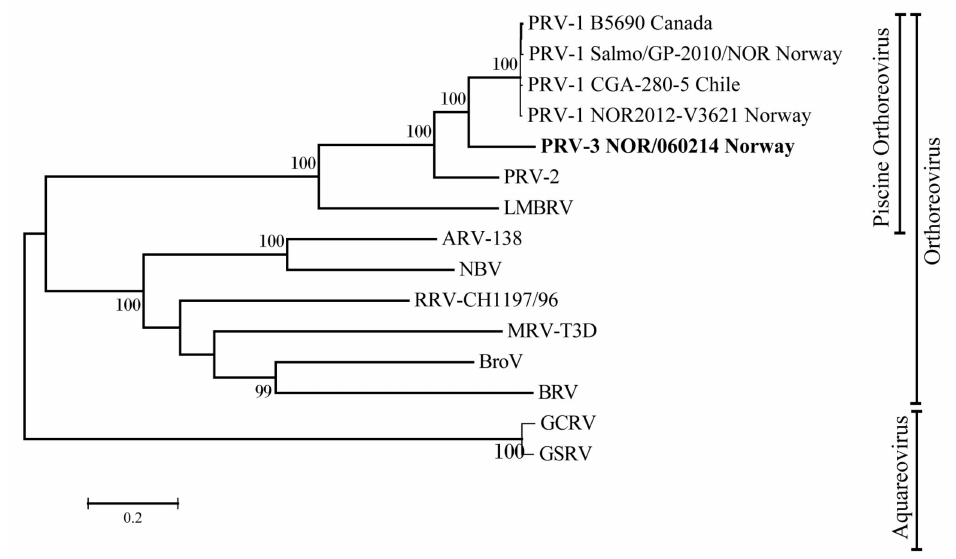
Figure 5. Phylogenetic tree based on complete coding sequences of PRV-3 RdRp (L1) of orthoreoviruses and aquareoviruses. MRV = Mammalian orthoreovirus , ARV = Avian orthoreovirus , NBV = Nelson Bay orthoreovirus , RRV = Reptilian orthoreovirus , BroV = Broome virus , BRV = Baboon orthoreovirus, GCRV = Grass carp reovirus , GSRV = Golden shiner reovirus